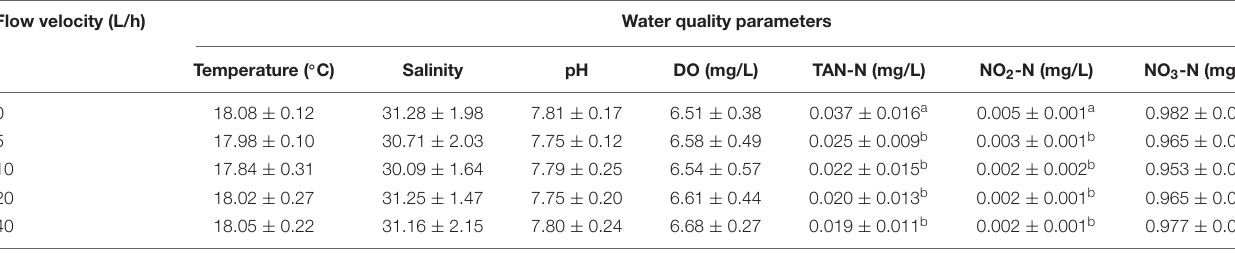
TABLE 2 | Effects of flow velocity on water quality parameters based on one-way ANOVA.